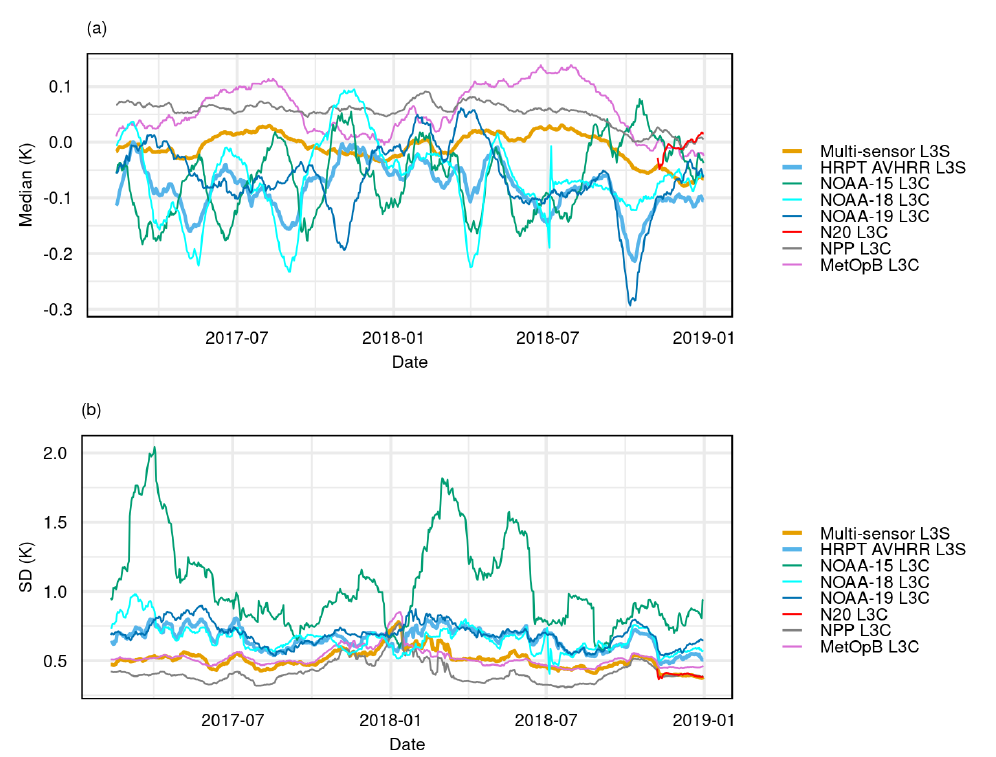
Figure 7. Bias-corrected fv02 L3C-1day and L3S-1day, QL ≥ 3, night only, monthly statistics, February 2017 to December 2018, ( a ) median and ( b ) standard deviation for NOAA–15 (green line), NOAA–18 (aqua line), NOAA–19 (violet line), NPP (grey line),NOAA-20 (red line), MetOp-B (pink line), HRPT AVHRR L3S (thick blue line) and Multi-sensor L3S (thick orange line), when compared with drifting and tropical moored buoys. Note: Matchup thresholds: < 10 km distance and < 6 h time difference. Data were obtained from